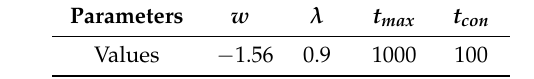
Figure 13. The plan of test site.